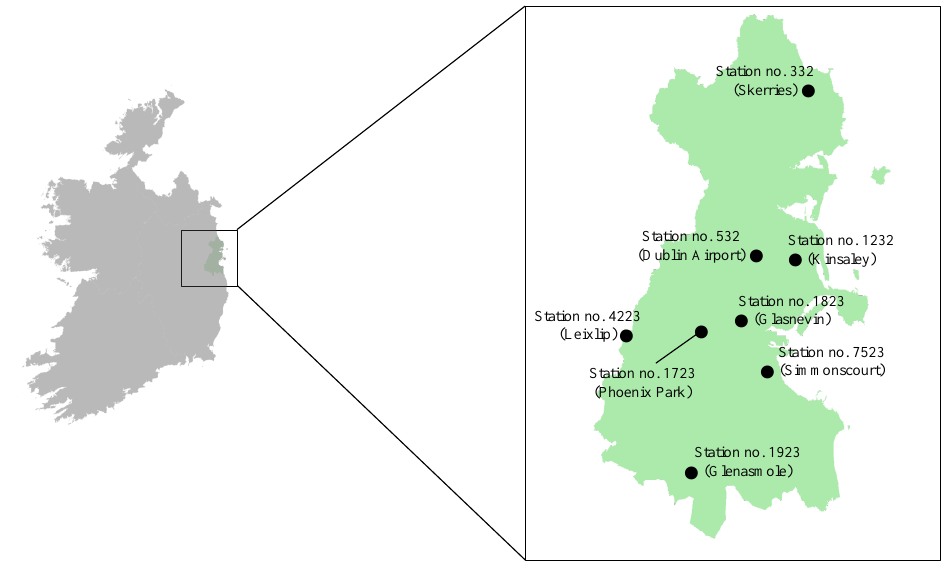
Figure 1. Names and locations of rainfall stations in study area.